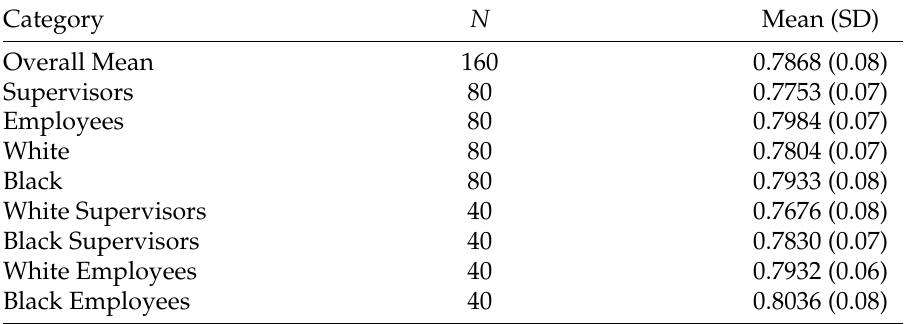
Table 5: Experiment 2 mean role-taking accuracy score